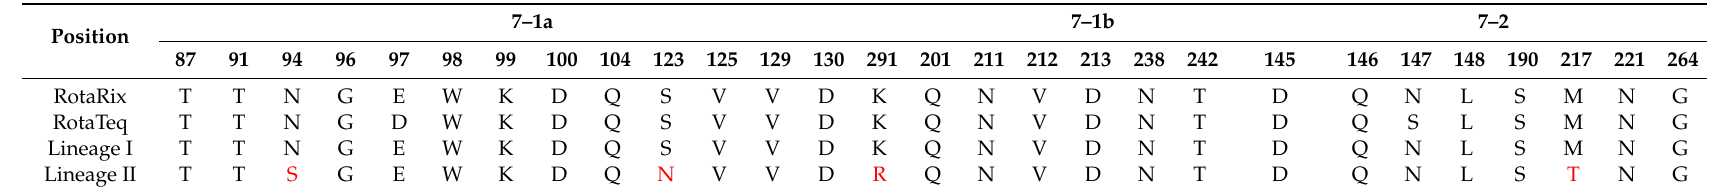
The di ff erent amino acid residues in lineage II are in red compared with lineage I and vaccine